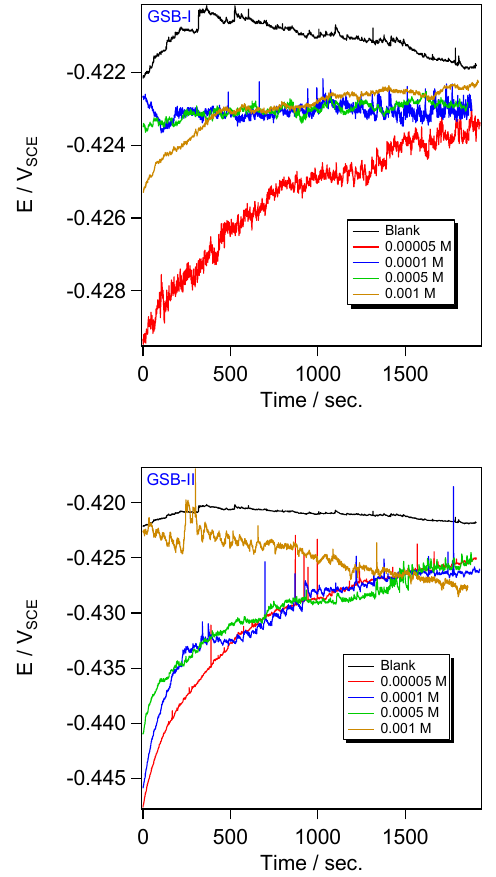
Figure 3. OCP plots for the API 5L X65 steel in 1 M HCl medium with different concentrations of the studied inhibitors at 298 K.